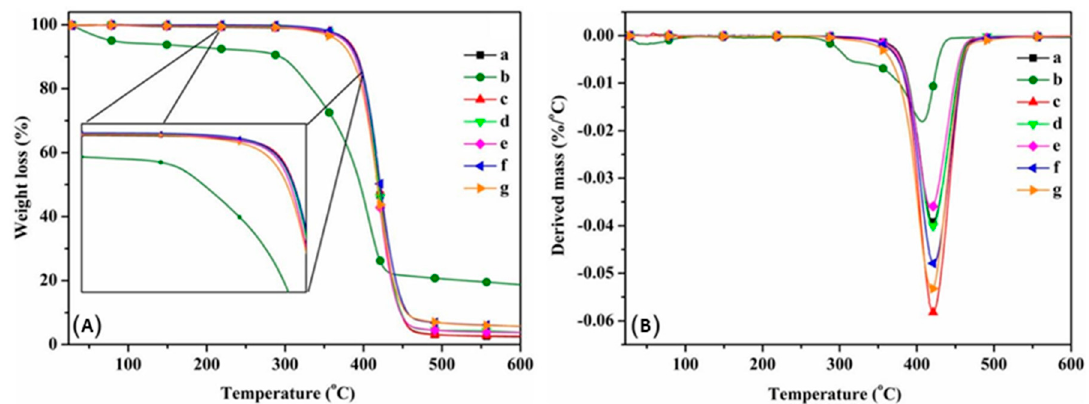
Figure 14. TGA ( A ) and DTG ( B ) of nanochitin sample and PBAT / chitin composites: ( a ) PBAT, ( b ) chitin, ( c ) chitin-0.5, ( d ) chitin-1, ( e ) chitin-2, ( f ) chitin-4 and ( g ) chitin-8 [80].